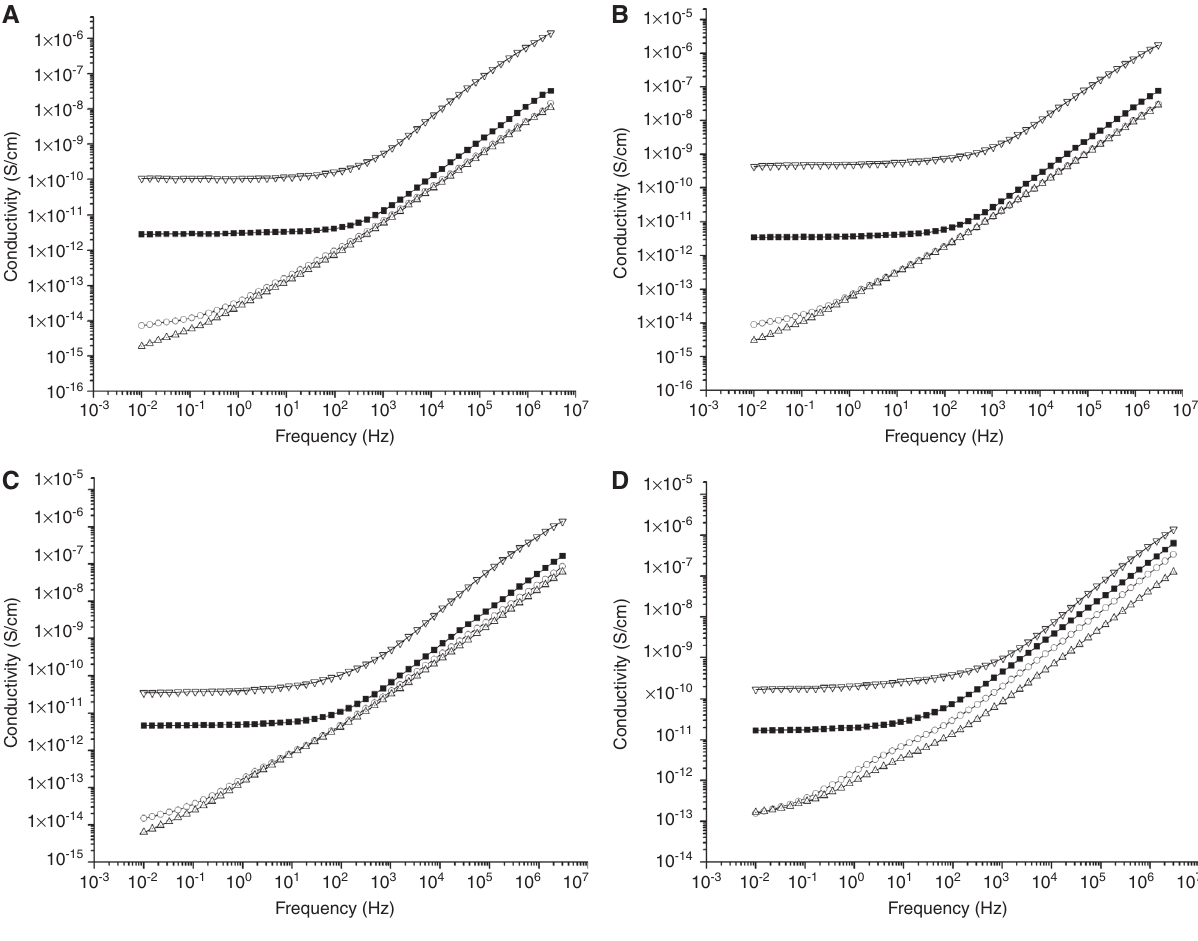
Figure 4 Conductivity ( σ ) at 120 ° C related to the frequency. (A) Compound+5% GTR, (B) compound+10% GTR, (C) compound+20% GTR, and (D) compound+50% GTR: ■, EVA; ○, HDPE; ∆, PP; ,